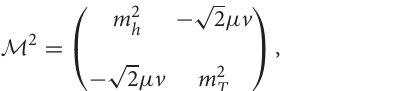
Thus the scalar sector constitute two CP-even Higgses: h and h t